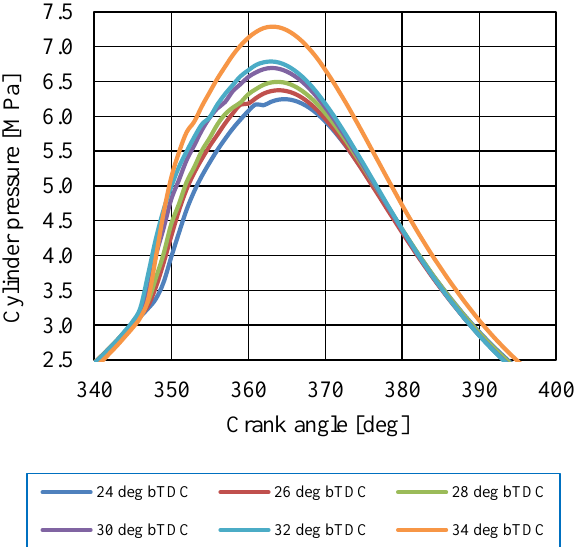
Fig. 6. Cylinder pressure vs. crank angle range 340–390 deg for a variable start of fuel injection, fuel: DF+10%PO